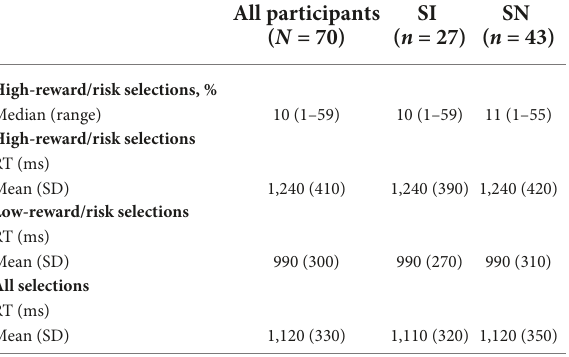
TABLE 3 Wheel of Fortune task behavior: Descriptive